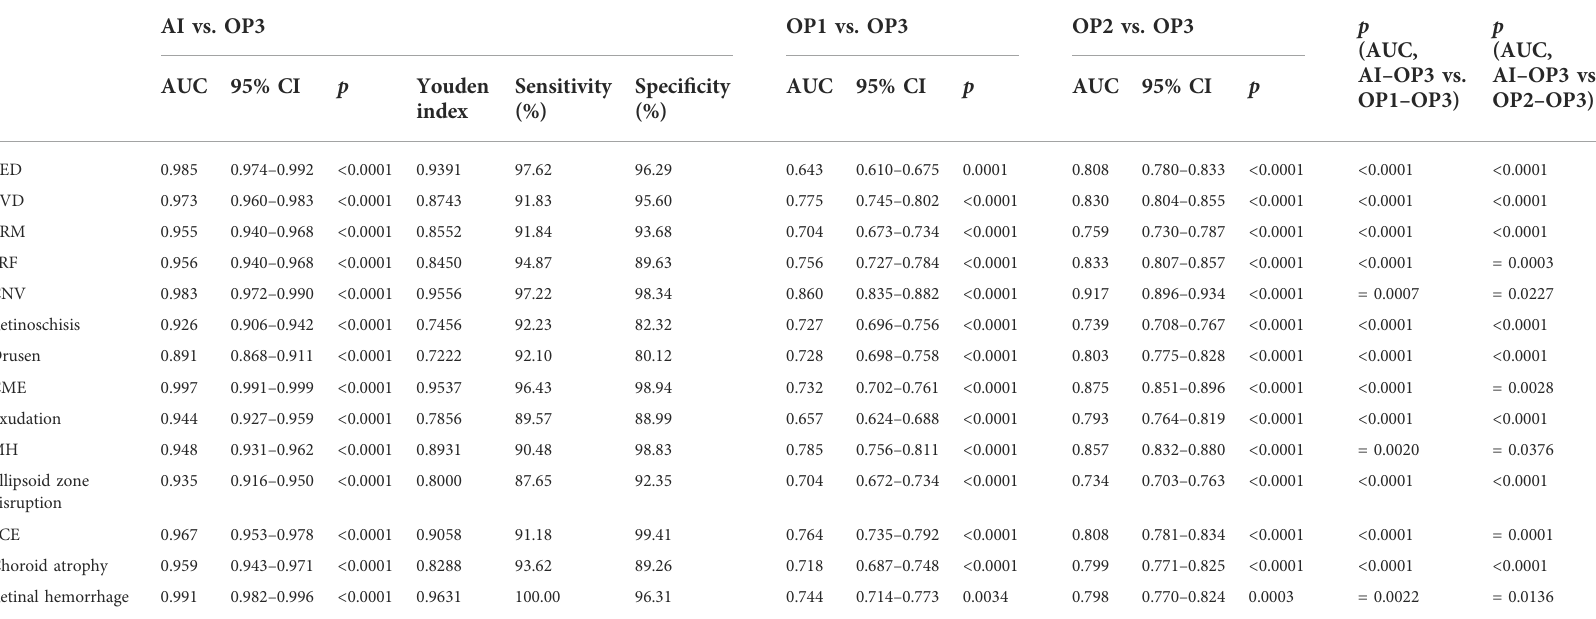
TABLE 2 AUC (with 95% CI), Youden index, speci fi city, and sensitivity in ROC of AI/group of junior ophthalmologists (OP1)/group of senior ophthalmologists (OP2) compared to the group of retinal specialists (OP3, as the golden standard). AI vs.